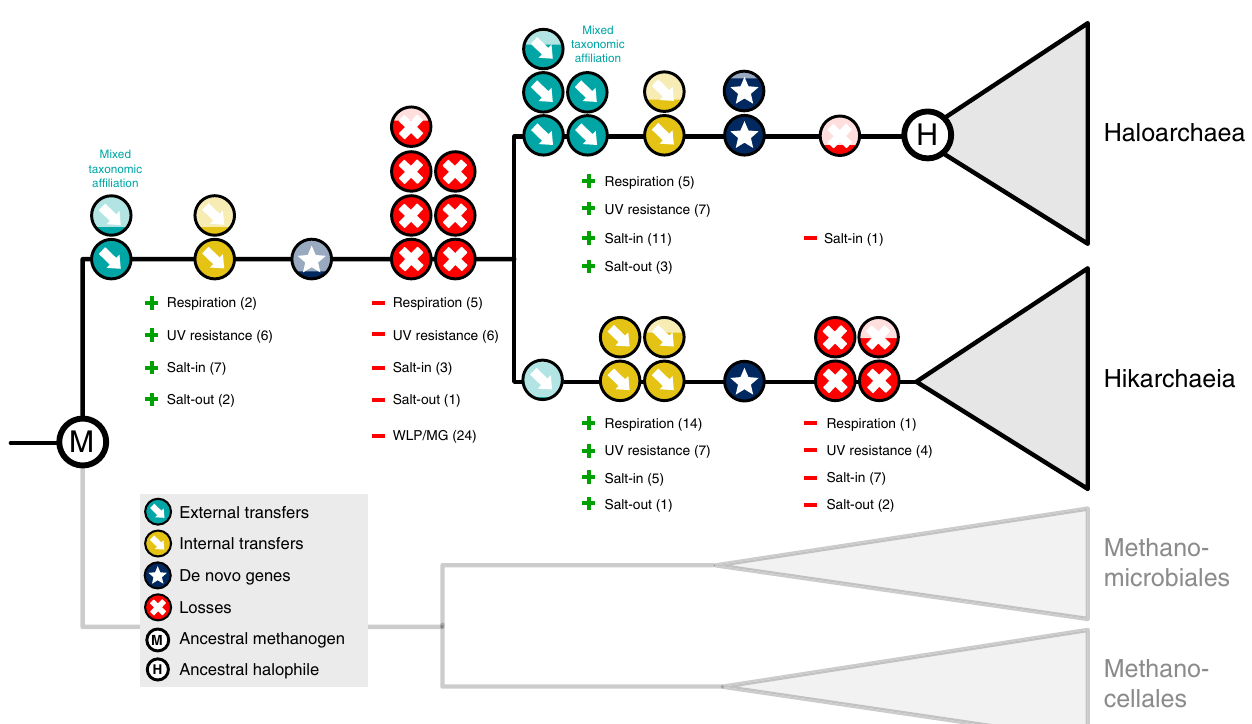
Fig. 6 Model of methanogen-to-halophile transition. Cartoon depiction of gene fl ow associated with the methanogen-to-halophile transition. Arrows, stars and crosses on the branches indicate an approximate quanti fi cation of number of transfers (external: from outside the species tree, internal: from inside the species tree), de novo genes and gene losses, respectively. Number of gene gains (transfer or origination ≥ 0.3; + ) and losses (loss ≥ 0.3; − ) for gene families related to respiration, methanogenesis and salt and UV adaptation are indicated below the branches. WLP Wood – Ljungdahl pathway, MG methanogenesis. Their detailed gene fl ows are visualized in Supplementary Figs. 24 and